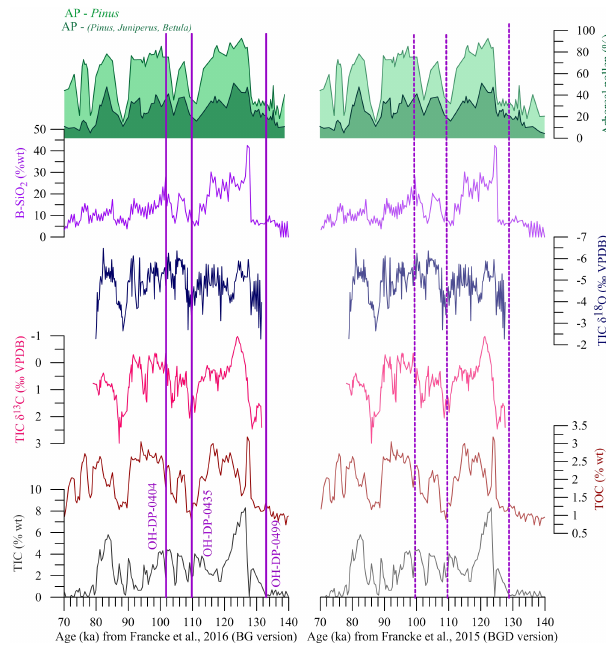
Figure 2. DEEP site proxy series plotted on age models from Francke et al., 2016 (left) and Francke et al. (2015; right). From top: B-SiO 2 after Francke et al. (2016), AP% (Arboreal Pollen, without considering Pinus spp. pollen grains) after Sadori et al., 2016; TIC δ 13 C after Lacey et al. (2016); TIC δ 18 O after Lacey et al. (2016); TOC and TIC % after Francke et al. (2016). Violet lines indicate tephra